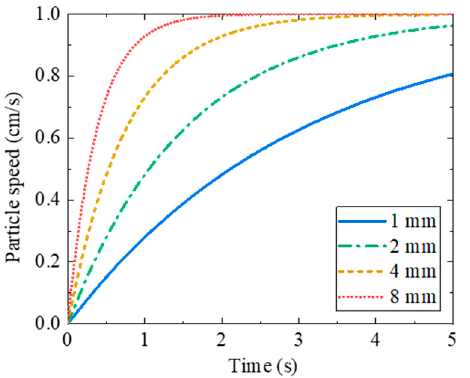
Figure A1. Comparison of particle behaviors on uniform flow field represented by DEM when the CG particle masses equal to the original particle.